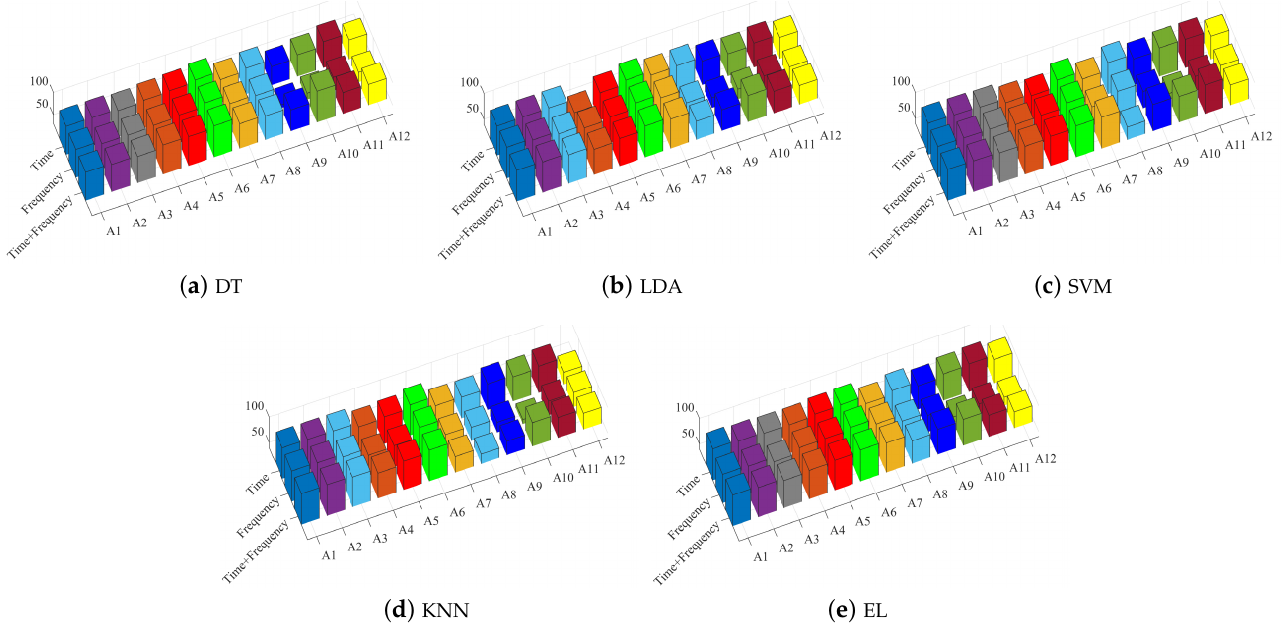
Figure 7. Action classification results under different classifiers. ( a ) Classification effect of action features on DT. ( b ) Classifi- cation effect of action features on LDA. ( c ) Classification effect of action features on SVM. ( d ) Classification effect of action features on KNN. ( e ) Classification effect of action features on